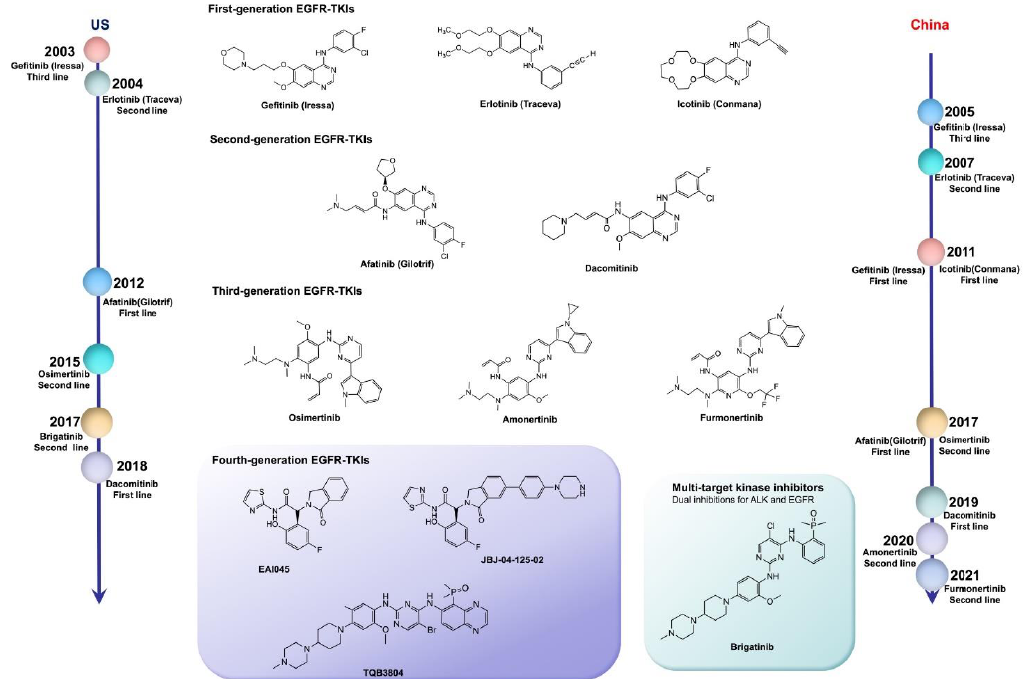
Figure 1. The timeline of EGFR-TKI discovery for targeted therapy of NSCLC in the U. S. and in China, respectively. EGFR- TKIs: epidermal growth factor receptor kinase inhibitors; ALK: anaplastic lymphoma kinase. Table 1. Clinical progress of first-/second-/third-generation EGFR-TKIs.